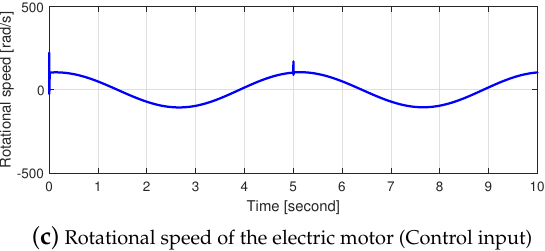
Figure 5. Position tracking performance of the proposed method in simulations with the sinusoidal